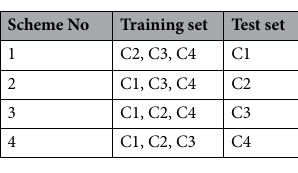
Table 4. Cross-validation schemes.